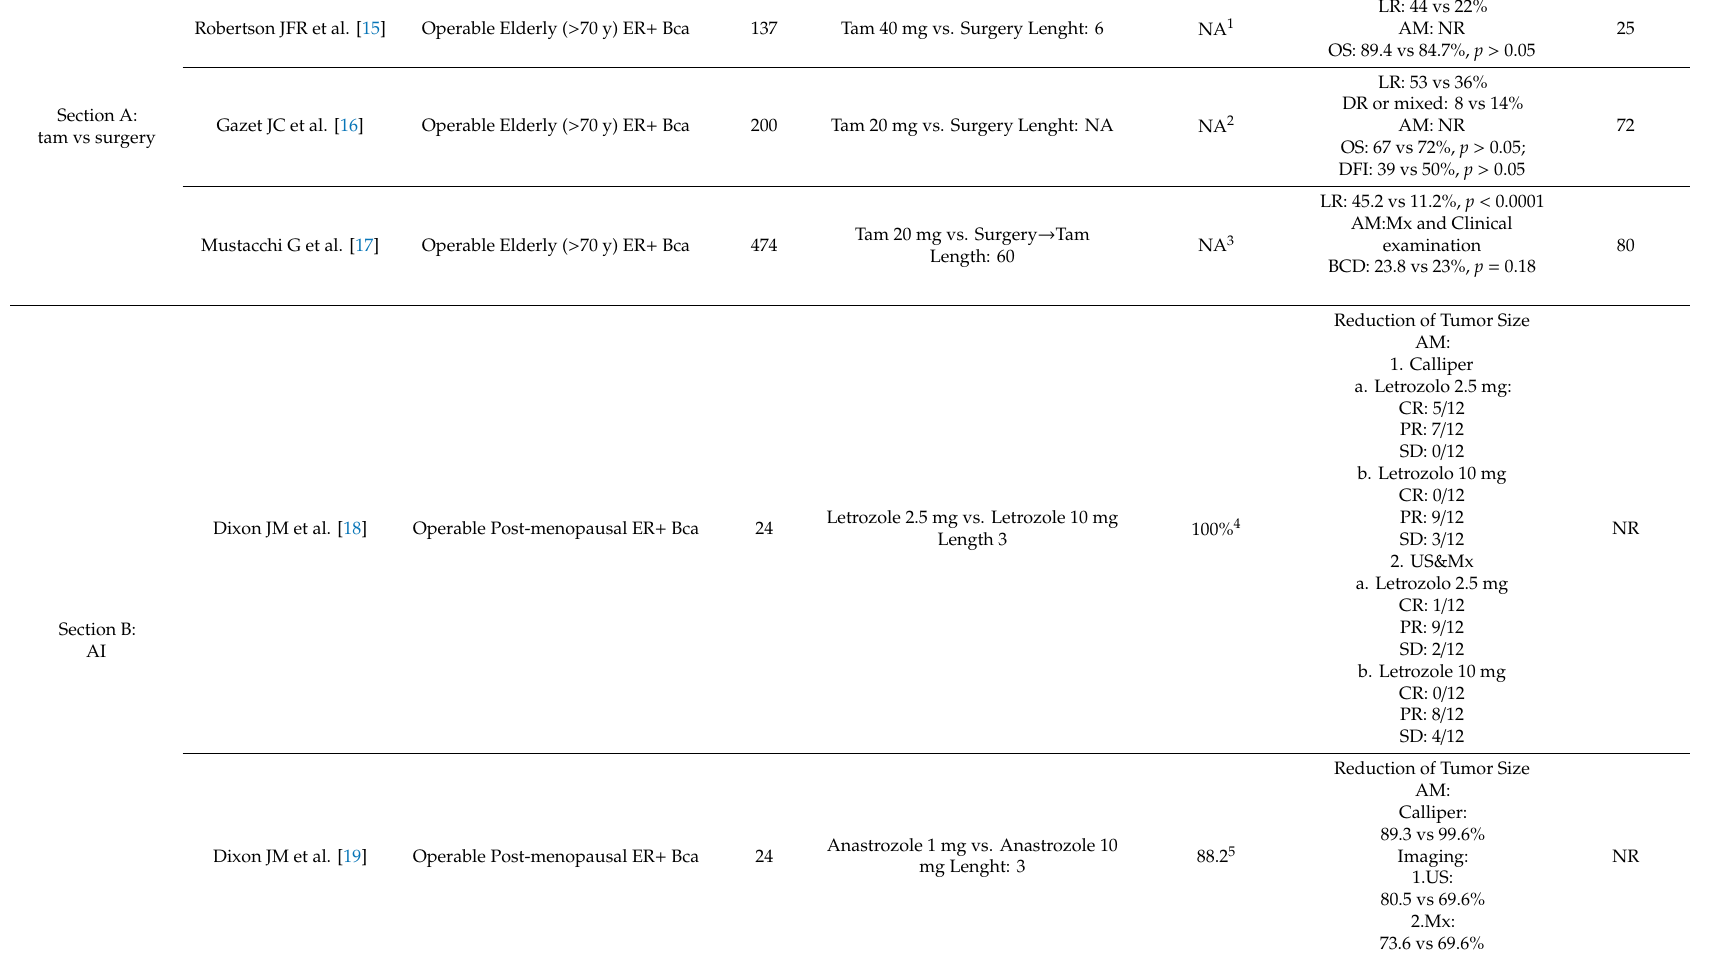
Table 1. Clinical trials of tamoxifen vs. surgery (section A); Aromatase inhibitors’ monotherapy (Section B) and aromatase inhibitors vs. tamoxifen (section C).